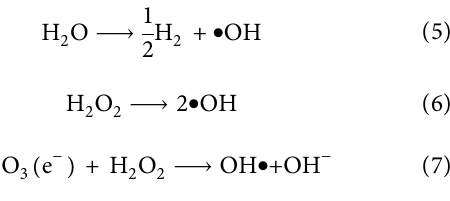
Figure 9: (a) Efect of hydrogen peroxide and (b) efect of potassium persulphate on eosin yellowish removable after 10min exposure